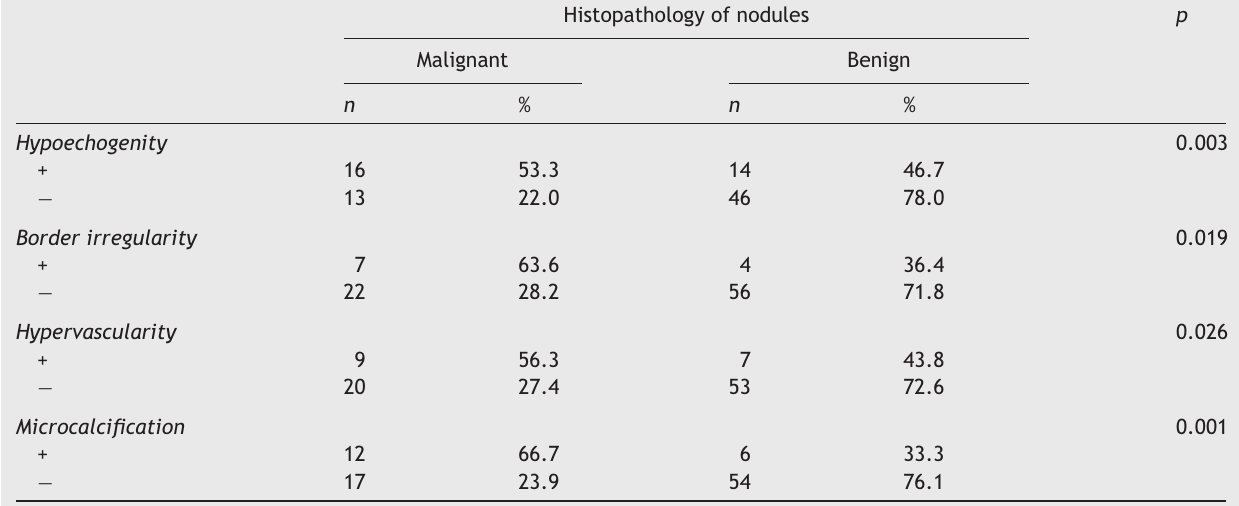
Malignancy rates of the nodules with and without suspicious sonographic features. Histopathology of nodules